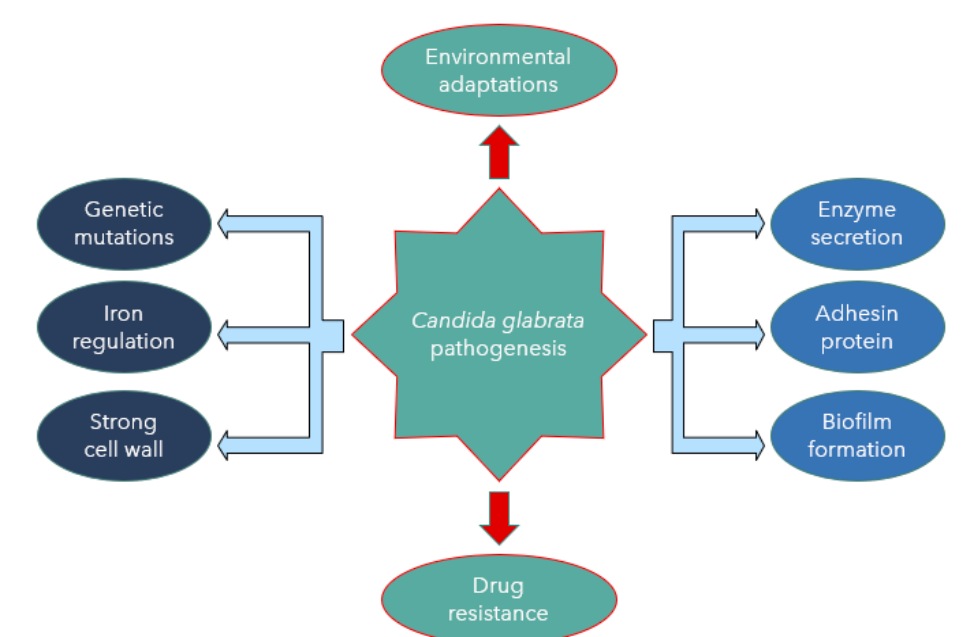
Figure 1. Candida glabrata pathogenesis mediated by virulence factors.